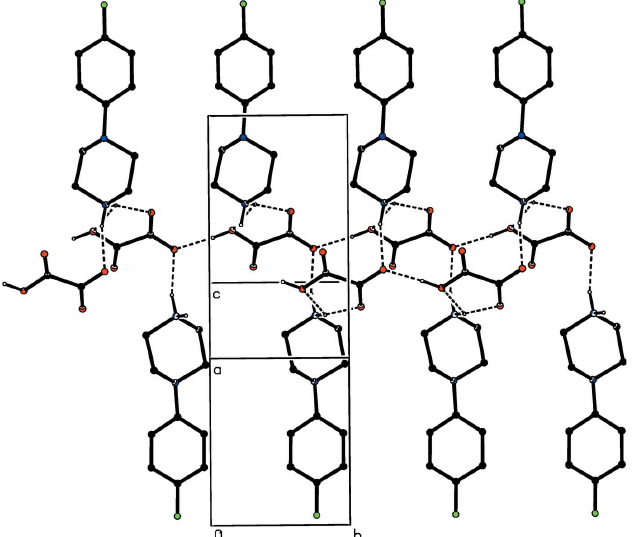
Figure 4 Part of the crystal structure of compound (I) showing the formation of a hydrogen-bonded chain of rings running parallel to [001]. Hydrogen bonds are drawn as dashed lines and, for the sake of clarity, the H atoms bonded to C atoms have been omitted.